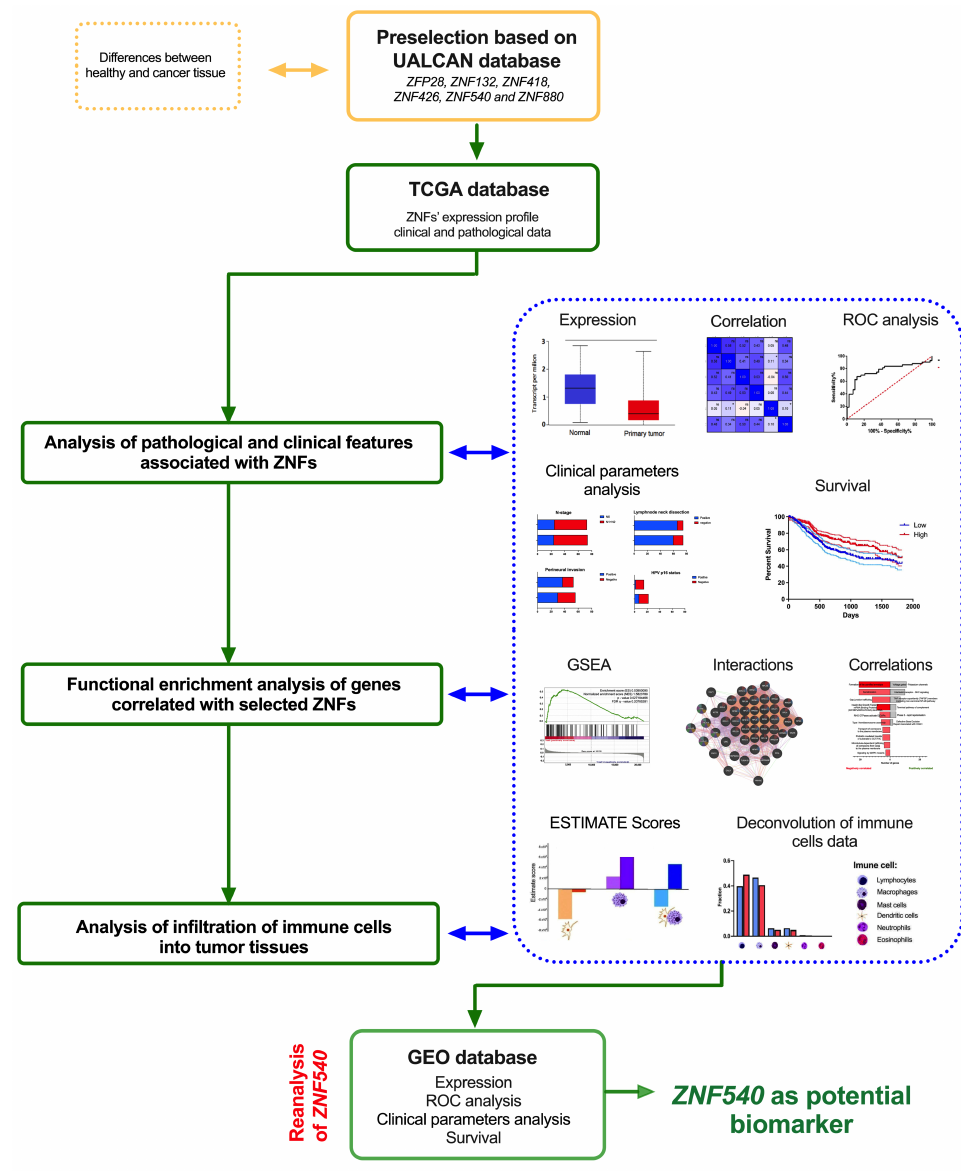
Figure 1. The main steps of the methodology and tools used in the presented study. UALCAN—The University of Alabama at Birmingham CANcer data analysis Portal; TCGA—The Cancer Genome Atlas; ROC—Receiver operating characteristic; ESTIMATE Scores—Estimation of Stromal and Im- mune cells in Malignant Tumor tissues using Expression data; GSEA—Gene Set Enrichment Analysis; GEO—Gene Expression